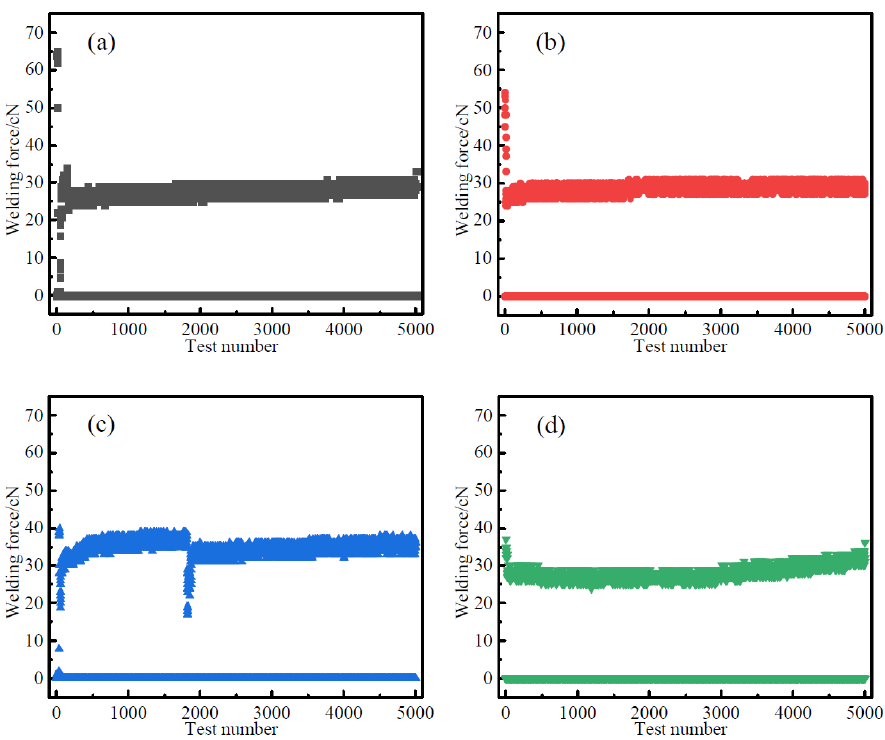
Figure 10. Variation in welding force of Cu-W composite contacts with different W contents: ( a ) Cu; ( b ) Cu-10 wt% W; ( c ) Cu-20 wt% W; ( d ) Cu-30 wt%